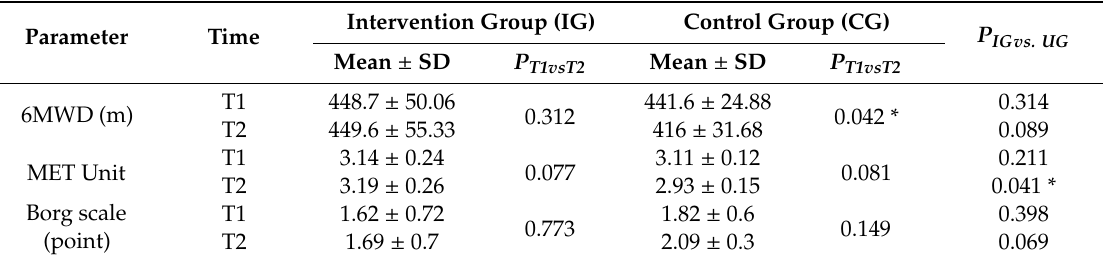
Table 3. Results of physical capacity tests in the study